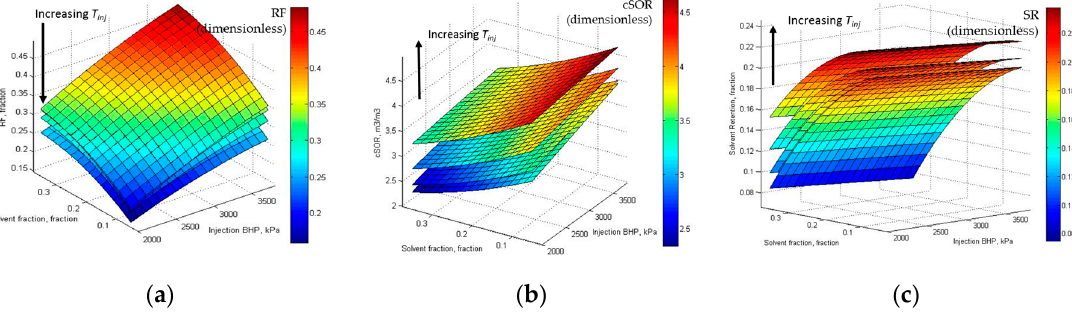
Figure 6. Response surfaces for the three objectives corresponding to four values of pure-steam injection period T inj (6, 12, 18, and 24 months): ( a ) recovery factor (RF); ( b ) cumulative steam–oil ratio (cSOR); and ( c ) solvent retention